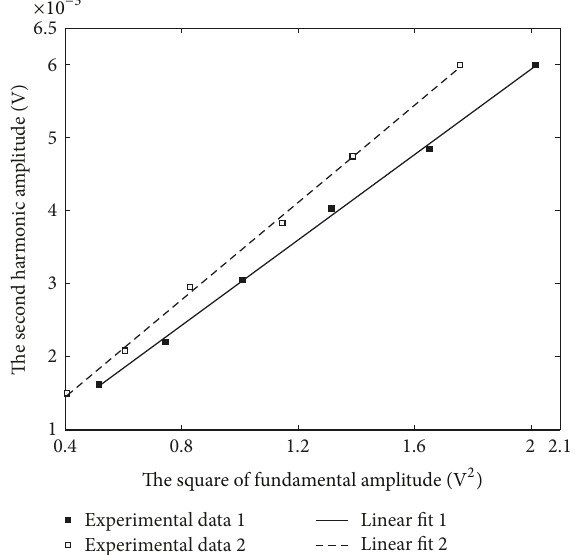
Figure 7: Second harmonic amplitude versus the square of fun- damental amplitude for the input voltage increasing from 300 V to 400